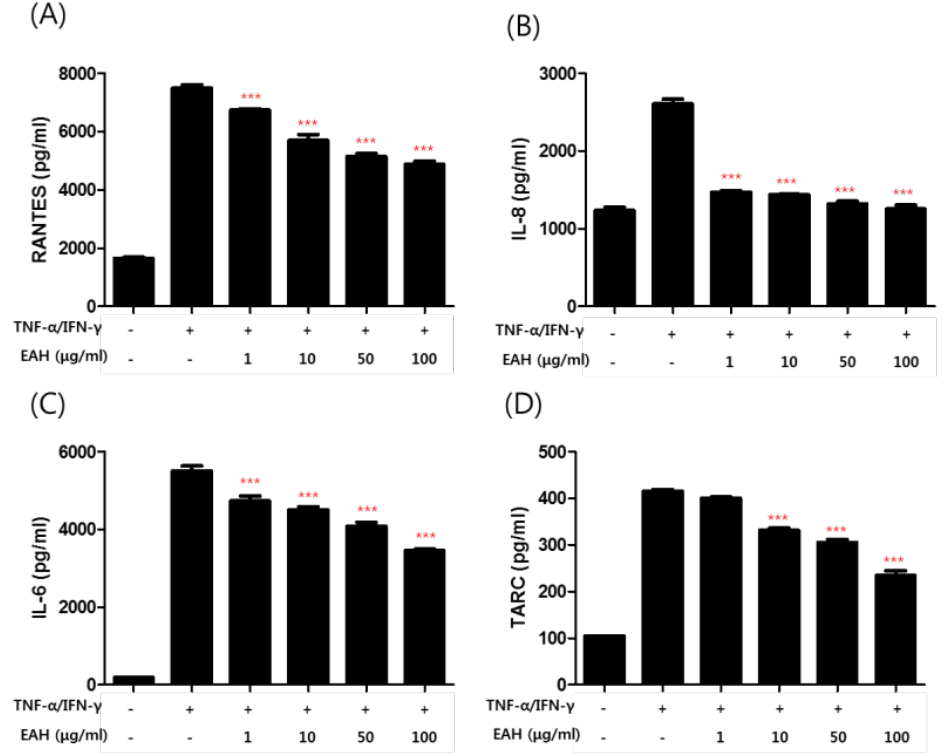
Figure 2. Effects of EAH on the TNF- α /IFN- γ –induced production of chemokines in HaCaT cells. The productions of RANTES ( A ), IL-8 ( B ), IL-6 ( C ), and TARC ( D ) were measured by using the culture supernatant of TNF- α /IFN- γ –stimulated HaCaT cells. The cells were pretreated with the indicated concentrations of EAH for 1 h and then stimulated with TNF- α /IFN- γ (each 10 ng/mL) for 24 h. Data are represented as mean ± SD of three independent experiments. *** p < 0.001 compared with the TNF- α /IFN- γ -treated group.